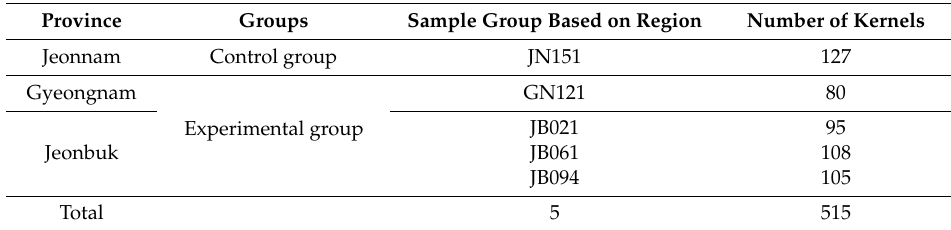
Table 1. Collection province and quantity of hulled barley samples used in experiment.